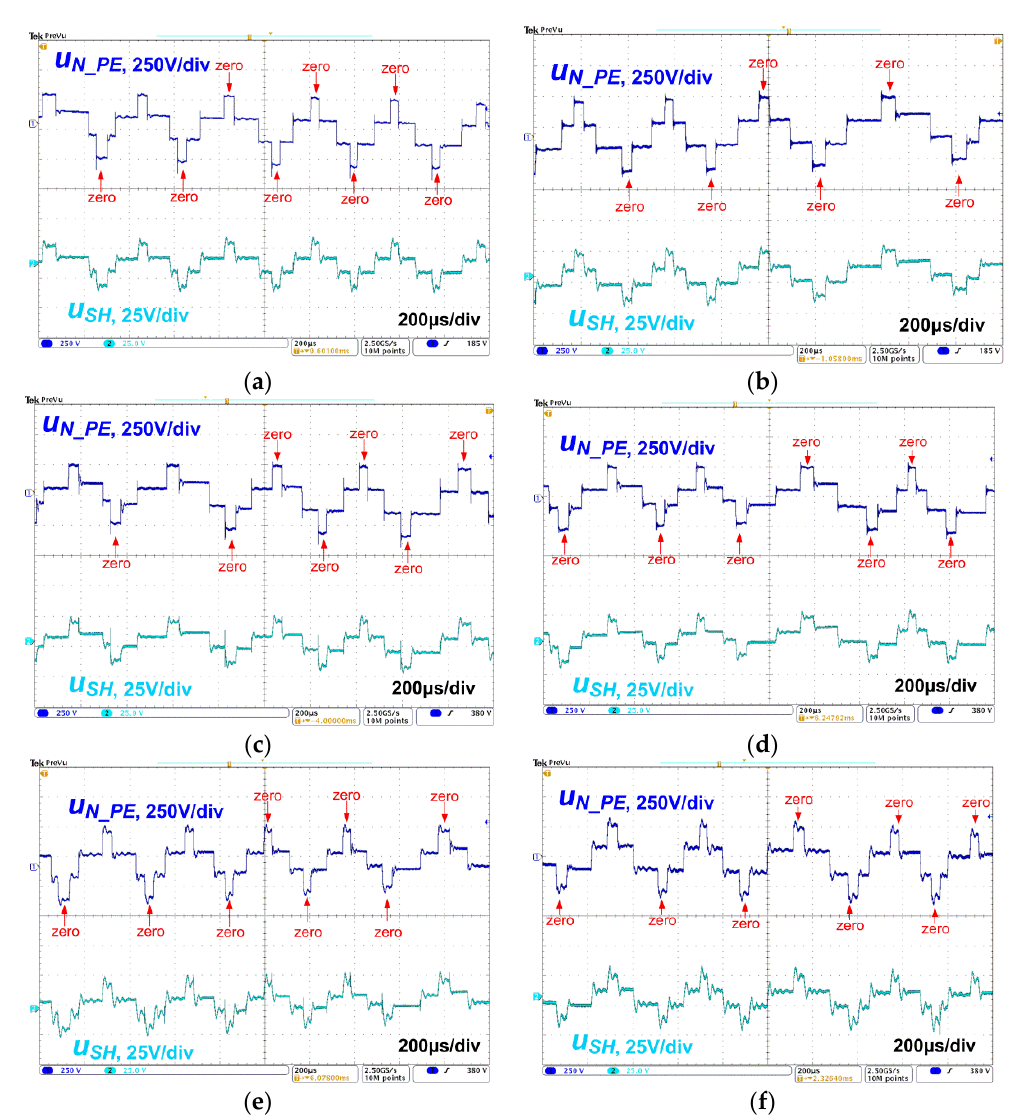
Figure 24. Experimental waveforms of CM voltage u N_PE and motor shaft voltage u SH measured in a configuration with a 1 m cable for: ( a ) inverter; ( b ) motor choke; ( c ) du/dt choke; ( d ) sine-wave filter; ( e ) CM choke; ( f ) CM choke with sine-wave filter.